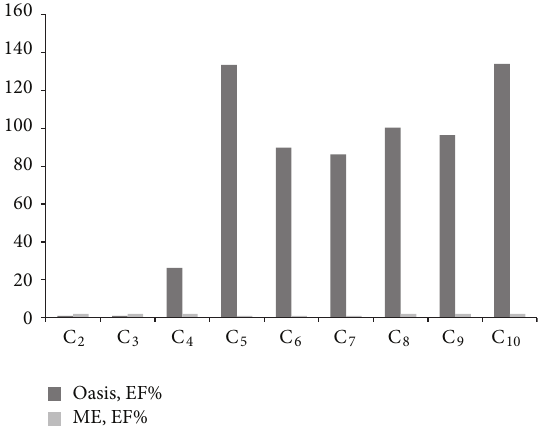
Figure 2: Comparison of enrichment in ME after circulating the samples twice with those made with SPE (Oasis HLB). Sample 25 × 25 cm 2 . The order of the analytes C 1 –C 10 is from left to right. The DCA concentration is 5mg/L. The results are averages of six replicates. The calculations are based on electropherograms of the standard mixture that were analysed after sample collection from the acceptor solution. 100% is normal recycling (see Experimental) and 2x recycling is twice the same sample volume (limited with timing). Analysis conditions as described in Experimental.